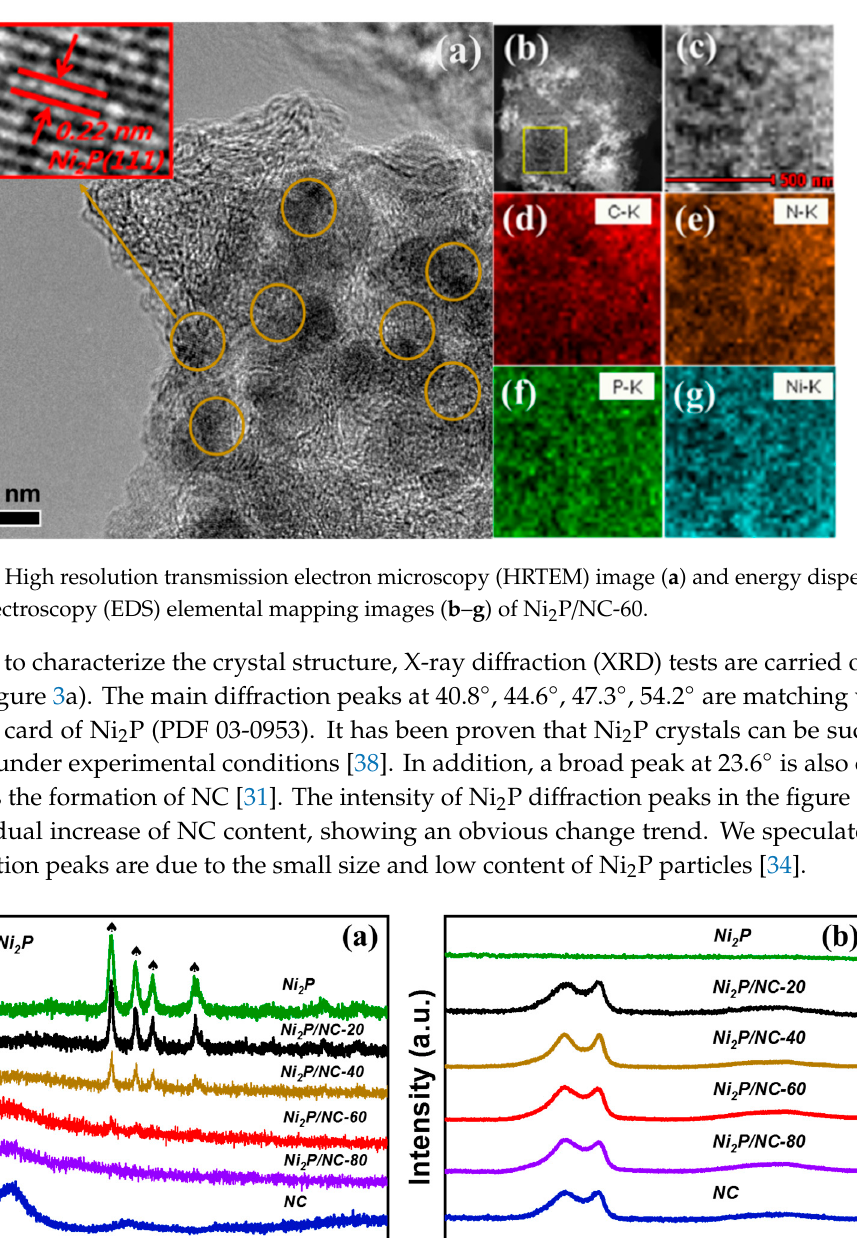
Figure 3. XRD patterns ( a ) and Raman spectra ( b ) of different components of materials.